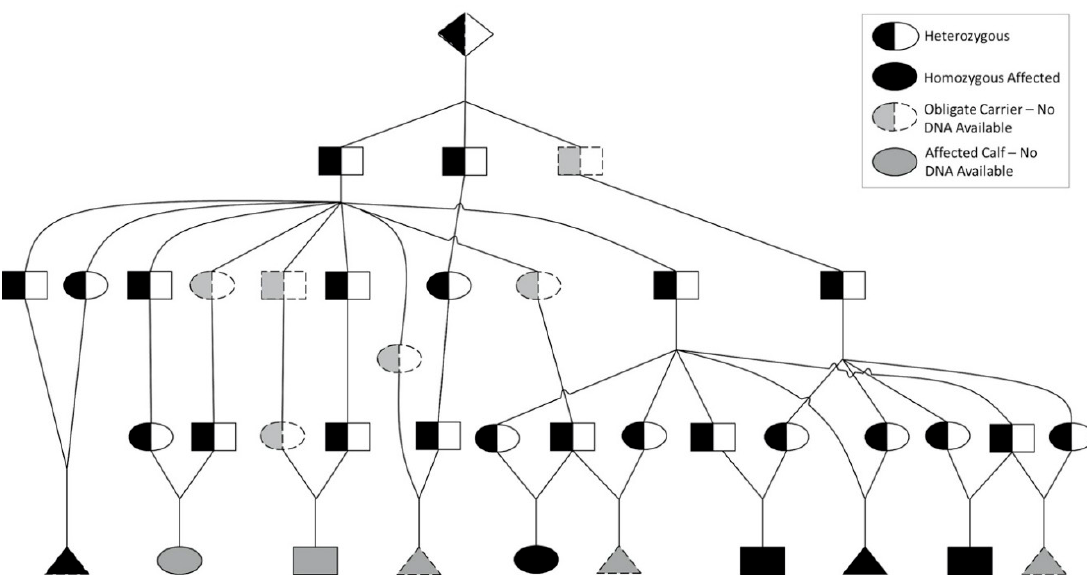
Figure 2. Pedigree of Affected Animals. Pedigree of all MD affected calves ( N = 10) including those in the WGS dataset and those reported after disclosure of the MD defect to the breed association membership (males = rectangles, females = ovals, unknown sex = triangles, presumed founder = diamond). Animals for which DNA was not available are shown in grey; all others (black) were genotyped for the CYP26C1 variant.